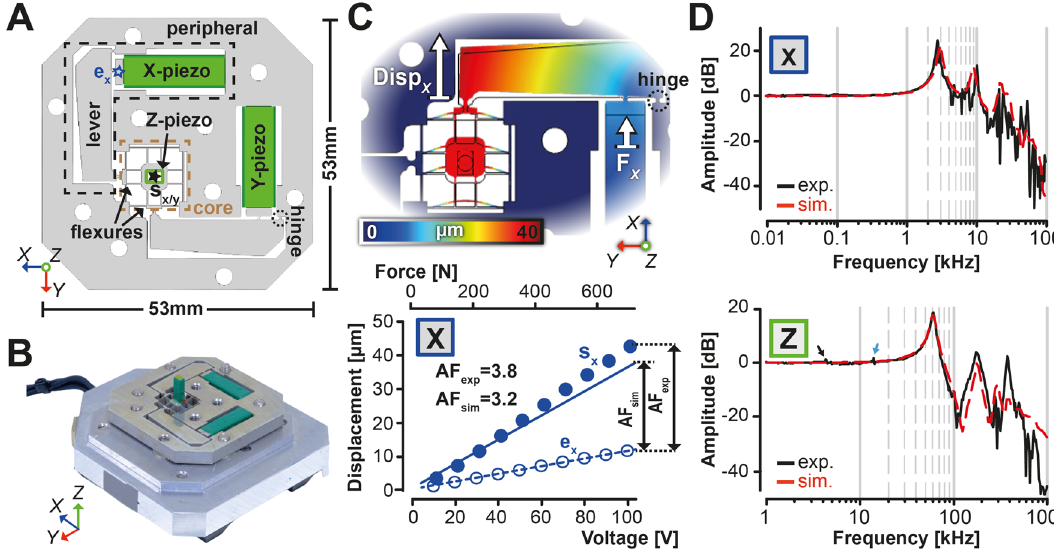
Figure 1. Design and characterization of a flexure-based ultra-wide high-speed scanner. ( A ) Schematic top view drawing of the ultra-wide scanner highlighting structural features of the scanner and its class 3 lever amplification mechanism. ( B ) Photograph of the fully assembled ultra-wide nano-positioner. ( C ) Upper panel: Displacement map of the x-scanner unit. Disp x : Amplified x-lever displacement. F x : force vector of the x-piezo actuator. Lower panel: Relationship between displacement and applied voltage/force at the effort point (e x ) and the stage centre (s x , y ) of the x-lever from measurements (blue open and filled symbols, respectively) and FEM (blue broken and solid lines, respectively). e x and s x,y location on the scanner are as indicated in ( A ). ( D ) Transfer function for the lateral piezo actuators (upper panel) and z-piezo actuator (lower panel) from experiments (solid black line) and FEM (red dashed line). ( A ) (upper panel), and ( C ) were generated using SolidWorks 26 (https:// www. solid works. com/) and COMSOL Multiphysics 5.6 (https:// www. comsol. com/), respectively. Individual plots in ( C , D ) were created using Matlab 2020b (https:// it. mathw orks. com/ produ cts/ matlab. html). Final figure was assembled, edited, and rendered with Adobe Creative Cloud suite (https:// www. adobe. com/ creat ivecl oud.